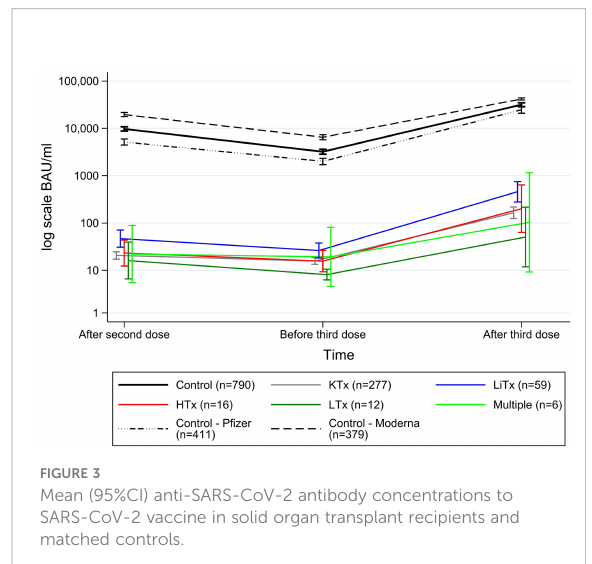
FIGURE 3 Mean (95%CI) anti-SARS-CoV-2 antibody concentrations to SARS-CoV-2 vaccine in solid organ transplant recipients and matched controls.